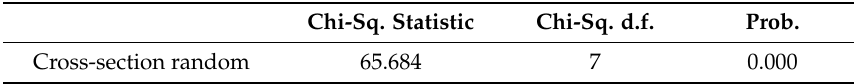
Table 5. Hausman test results.